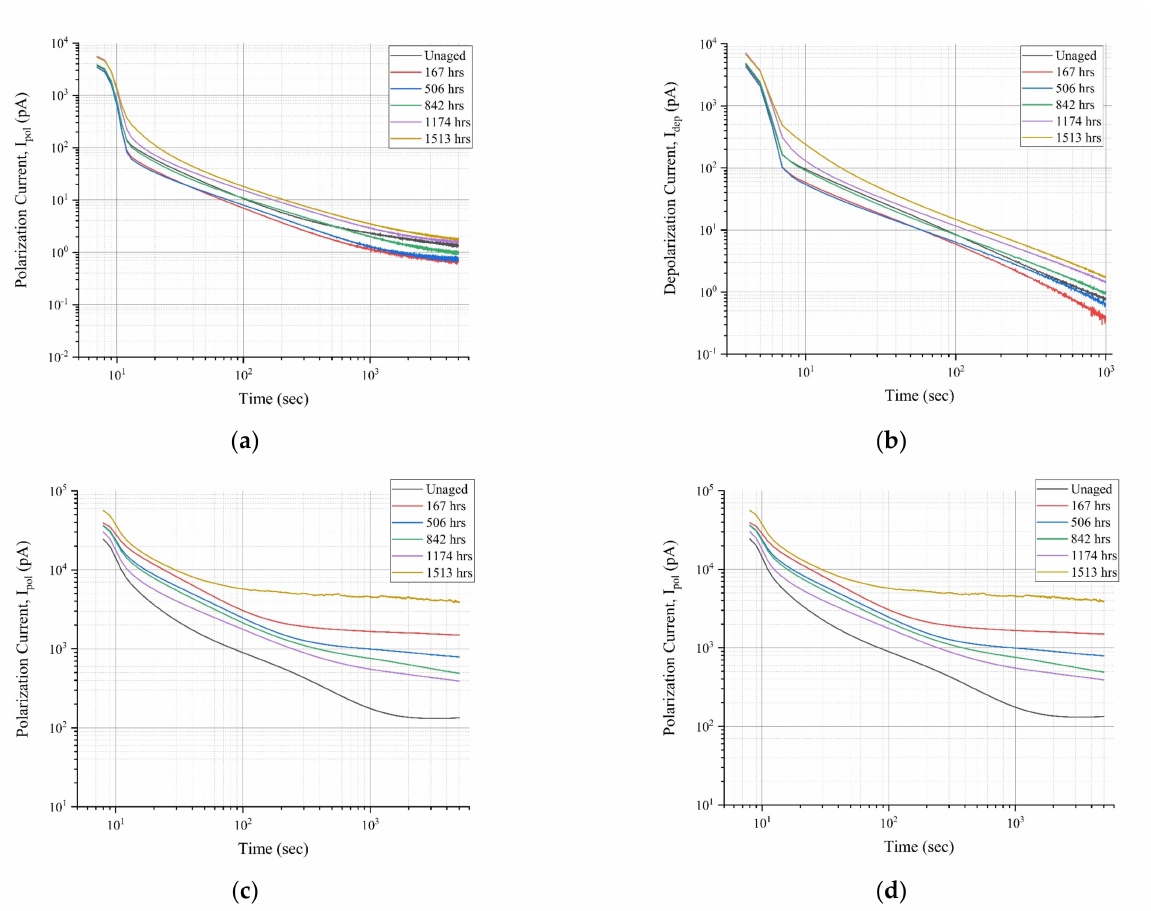
Figure 7. PDC measurement, EPR insulation: ( a ) polarization current, ( b ) depolarization current for different thermal aging periods, CSPE jacket, ( c ) polarization current, and ( d ) depolarization current for different thermal aging periods.